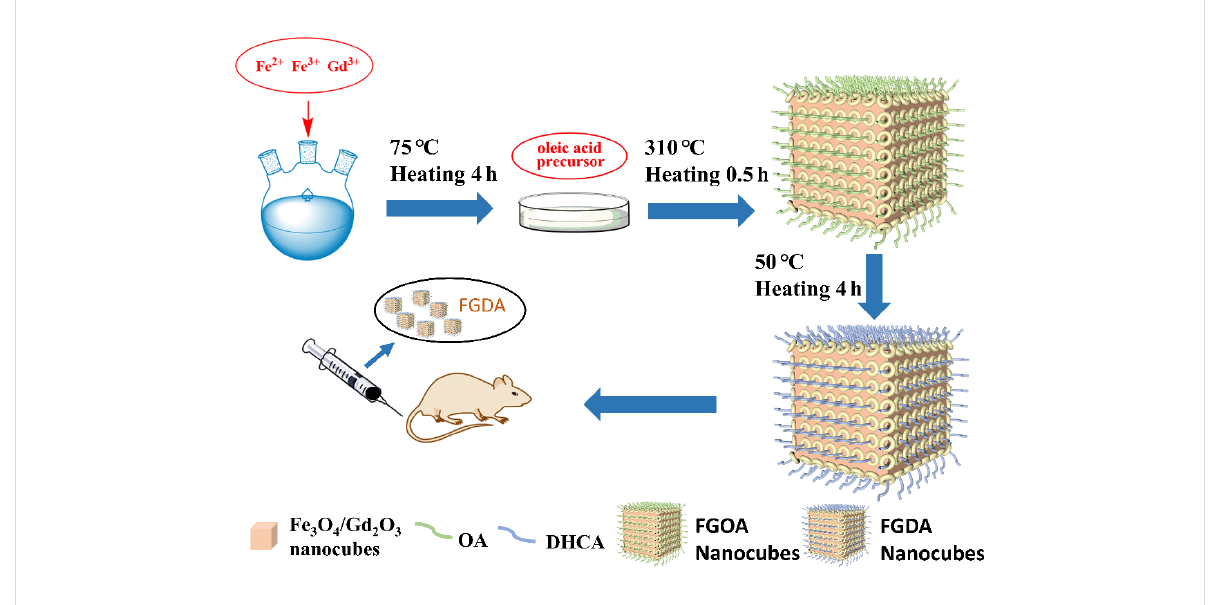
Figure 1: Schematic illustration of FGDA nanocube synthesis. Briefly, a mixture containing sodium oleate, water, ethanol and metal salts was added to a three-necked flask where it was heated and refluxed at 75 °C for 4 h. After cooling, the organic phase obtained was rinsed and dried, forming the metal oleic acid precursor. Next, the precursors were mixed with octadecene and the reaction was heated up to 310 °C and refluxed for 30 min. When the mixture cooled down to room temperature, ethanol was added to precipitate the FGOA nanocubes, which were pooled by centrifugation. After a few rinsing steps, FGOA nanocubes were added to a flask together with DHCA and THF and the mixture was heated up to 50 °C and re- fluxed for 4 h. After cooling down, NaOH was added to the reaction to precipitate the FGDA nanocubes, which were pooled by centrifugation and resuspended in ultrapure water to be used in in vivo MRI